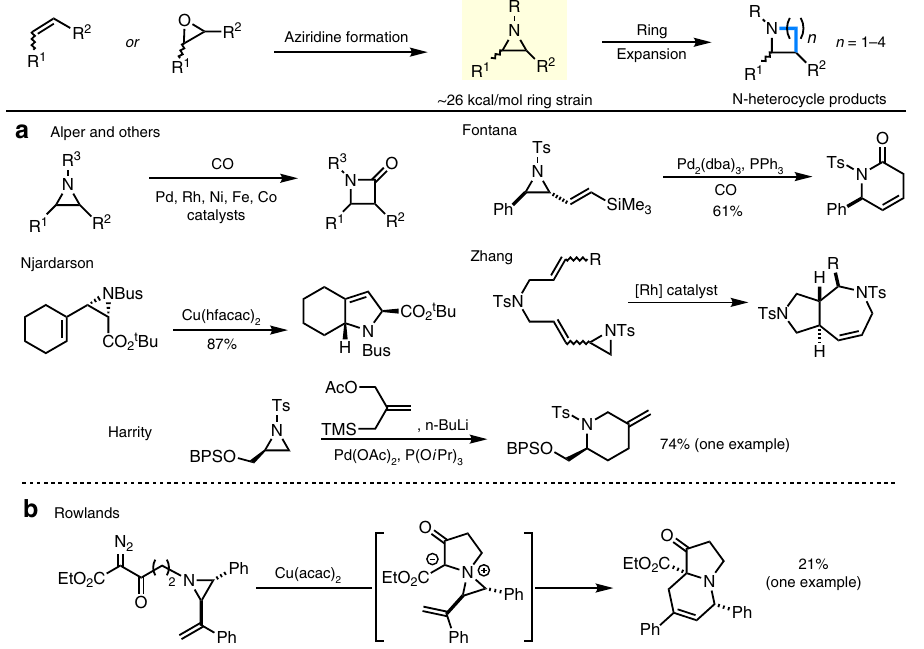
Fig. 1 Transformations of aziridines to N -heterocycles. a Typical transition metal-catalyzed ring expansions. b Cu-catalyzed aziridine ring expansion through the intermediacy of an aziridinium